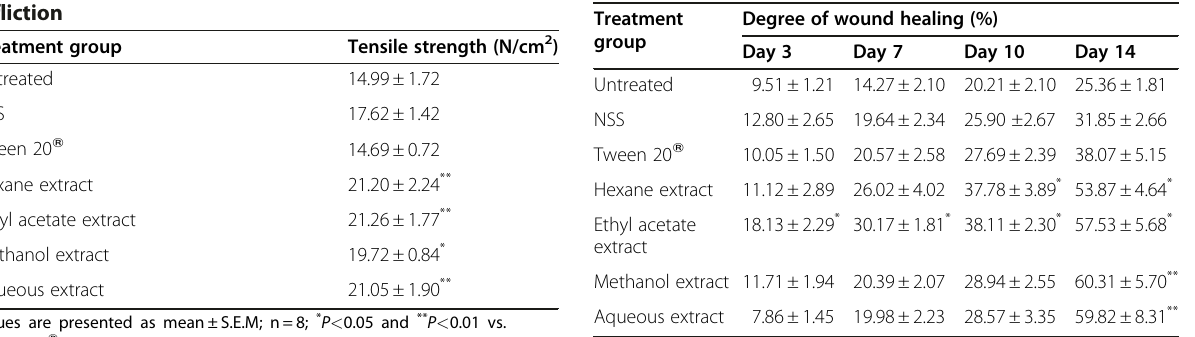
Table 2 Degree of healing of partial-thickness burn wounds treated with extracts of Centella